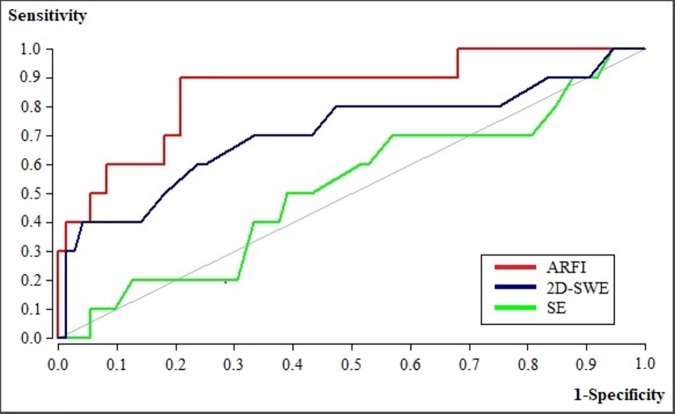
Comparison of ROC-Curves for SE, ARFI and 2D-SWE.